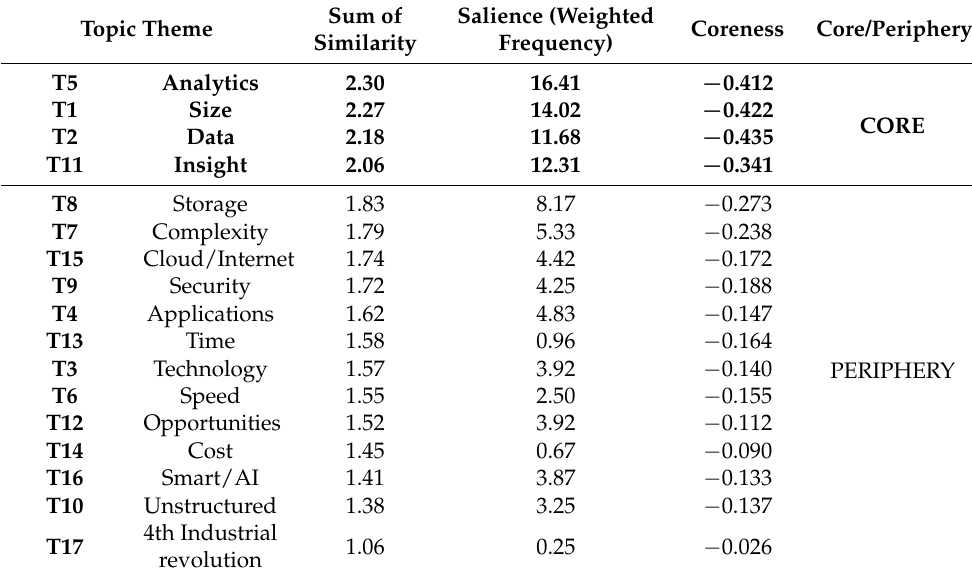
Table 5. Core/Periphery Structure of Big